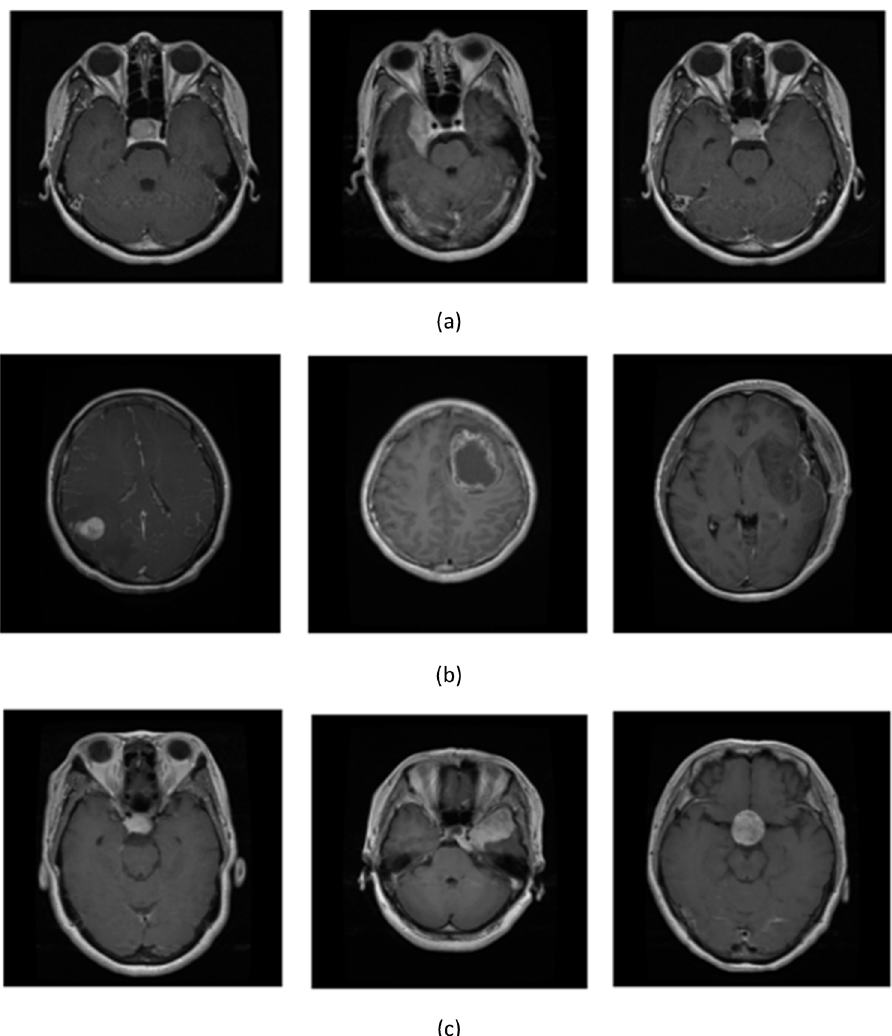
Figure 4: Sample images of ( a ) pituitary, ( b ) glioma, and ( c ) meningioma.